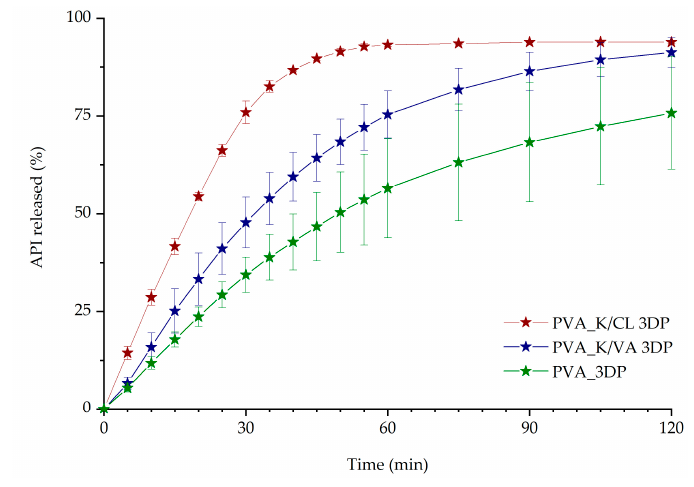
Figure 9. The influence of the excipients on dissolution profiles of itraconazole from 3DP tablets (infill density equal to 35%).